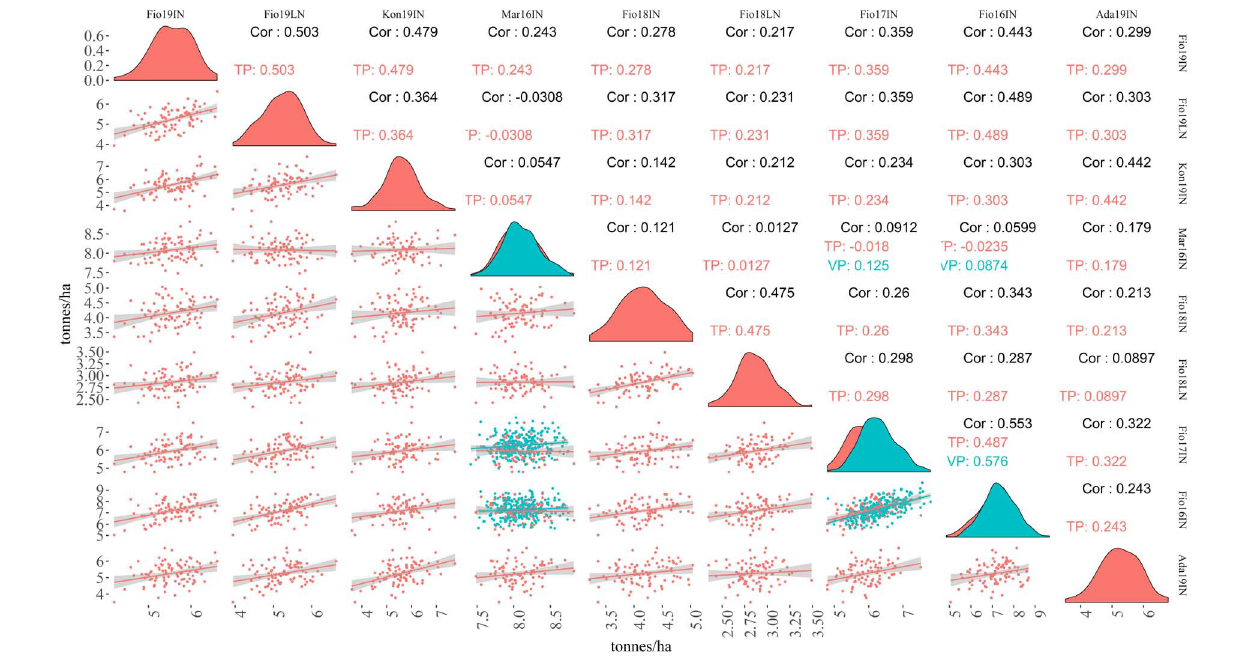
FIGURE 5 | Pairwise correlations of GY obtained in the nine site-by-season combinations for TP and VP. Numbers reported in black, red, and blue on the upper graph show pairwise Pearson correlations computed between adjusted means of GY for the whole set of lines tested, TP and VP, respectively. The lower graph shows scatter plots of GY adjusted means computed in pairs of site-by-season combinations. TABLE 4 | Variance components of SE-GP models fitted using GBLUP (GB) and GK statistical model. Site-by-season combination GB GK Genetic effect variance Residual variance Genetic effect variance Residual